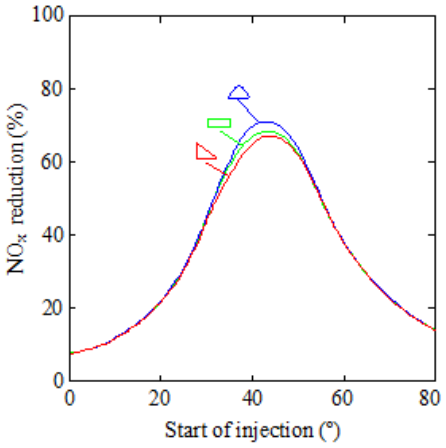
Figure 8. NO x reduction against the start of ammonia injection for rectangular (green color), triangular (red color), and parabolic (blue color) injection shapes using 10º injection duration.